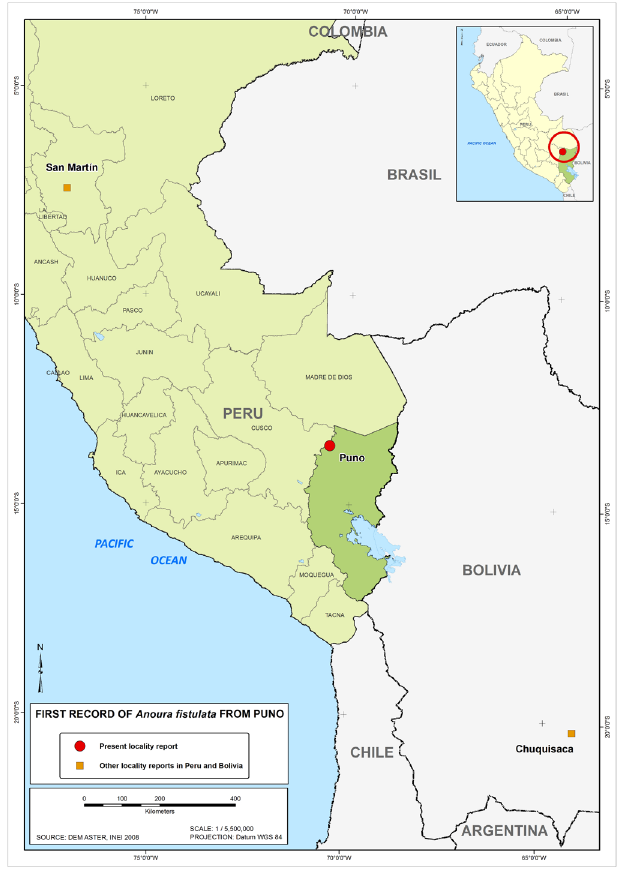
Figure 1. Location of the report